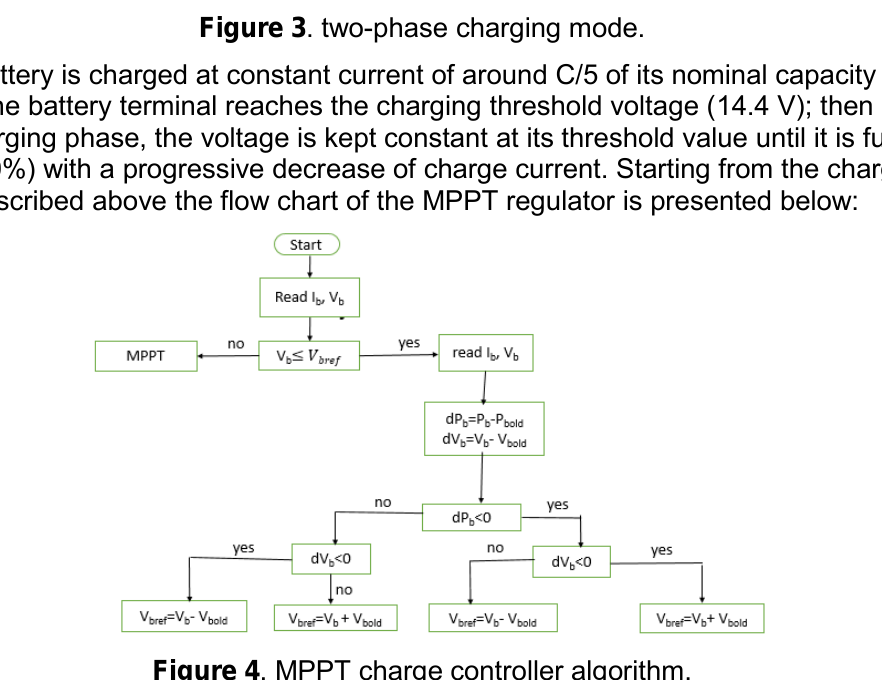
Figure 4 . MPPT charge controller